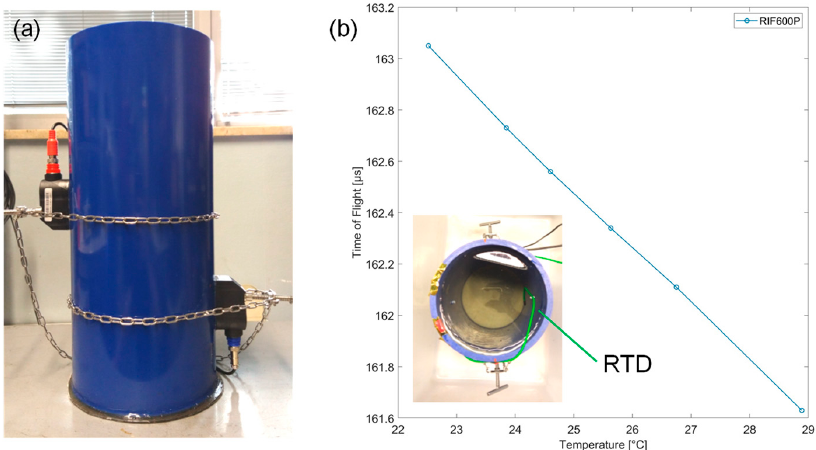
Figure 6. Water temperature measurement in a static setup ( a ) by means of the time of flight ( b ) of ultrasounds.